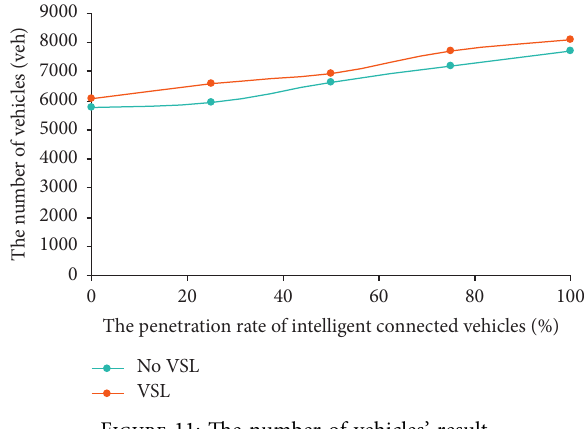
Figure 11: The number of vehicles’